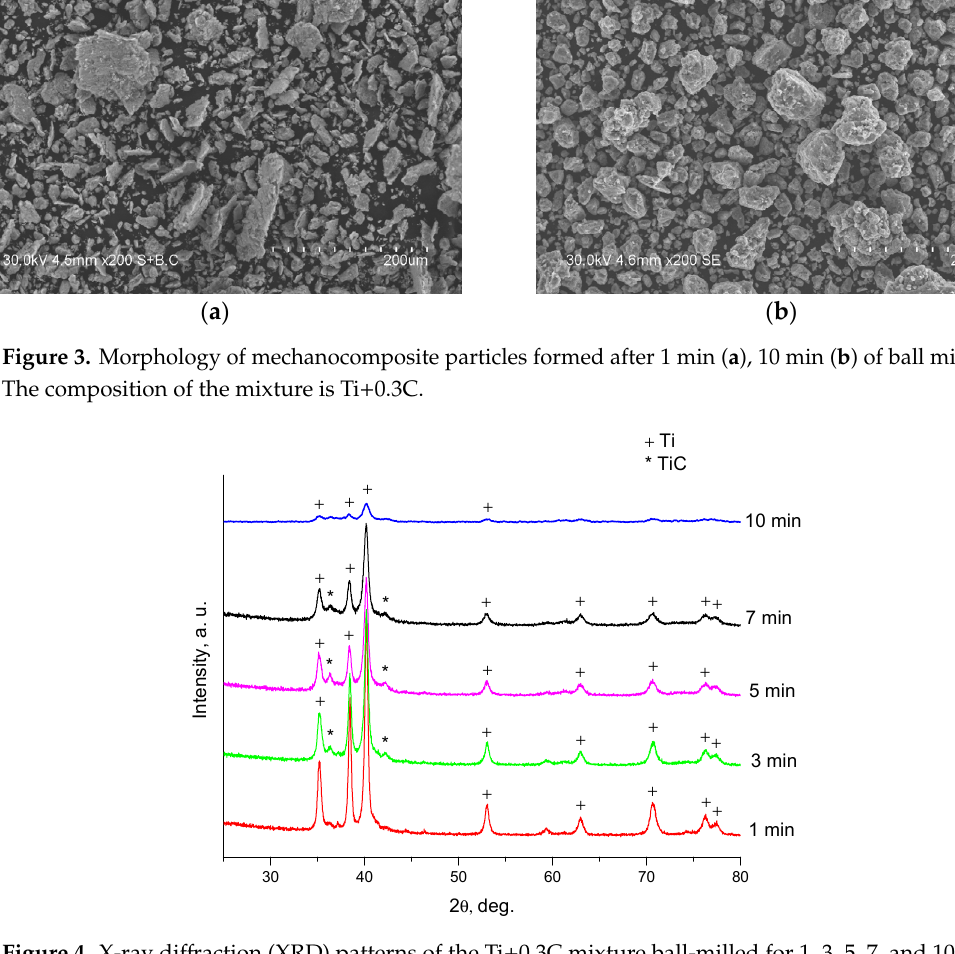
Figure 4. X-ray di ff raction (XRD) patterns of the Ti + 0.3C mixture ball-milled for 1, 3, 5, 7, and 10 min. Figure 4. X-ray diffraction (XRD) patterns of the Ti+0.3C mixture ball-milled for 1, 3, 5, 7, and 10 min. The composition of the mixture is Ti + 0.3C. Figure 4. X-ray diffraction (XRD) patterns of the Ti+0.3C mixture ball-milled for 1, 3, 5, 7, and 10 min. The composition of the mixture is Ti+0.3C. The composition of the mixture is Ti+0.3C. Figure 4. X-ray diffraction (XRD) patterns of the Ti+0.3C mixture ball-milled for 1, 3, 5, 7, and 10 min. The composition of the mixture is Ti+0.3C.